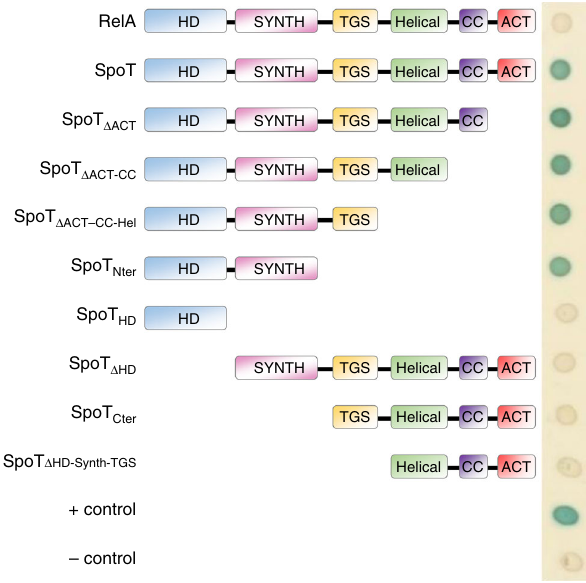
Fig. 6 YtfK can interact with the catalytic domain of SpoT in vivo. Bacterial two-hybrid assay with YtfK and several truncated version of SpoT. BTH101 strain harboring pUT18c ytfK and truncated pKT25 spoT were spotted on X-Gal agar base plates (see the Methods section). The blue color indicates a positive interaction. This experiment was repeated four times with identical results.